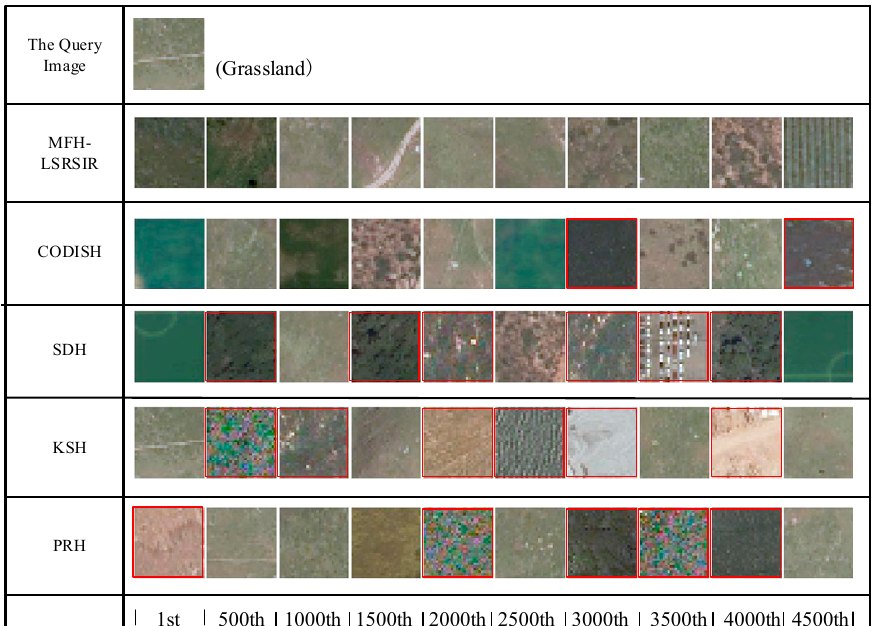
Figure 7. Visualized retrieval results of the SAT-4 dataset by different hashing methods with 64 bit hash codes. The red rectangles indicate incorrect retrieval results. The abscissa represents the sequence number of the image.